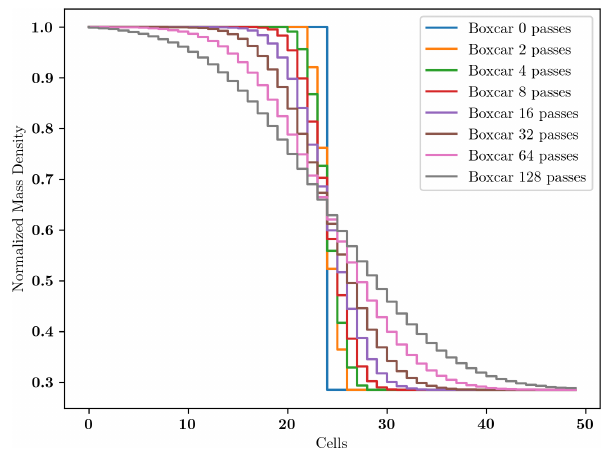
Figure 7. Smoothing of a step in mass density along a line in the simulation domain intersecting a discontinuity. The unfiltered nor- malized mass density line profile is shown in blue, and the other colors correspond to an increasing number of boxcar passes.